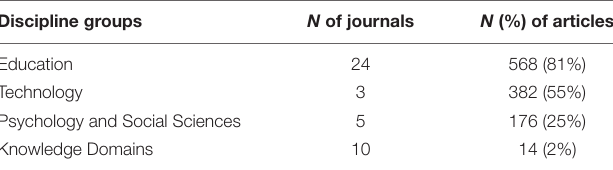
TABLE 4 | Discipline groups of the journals that publish CSCL research. Discipline groups